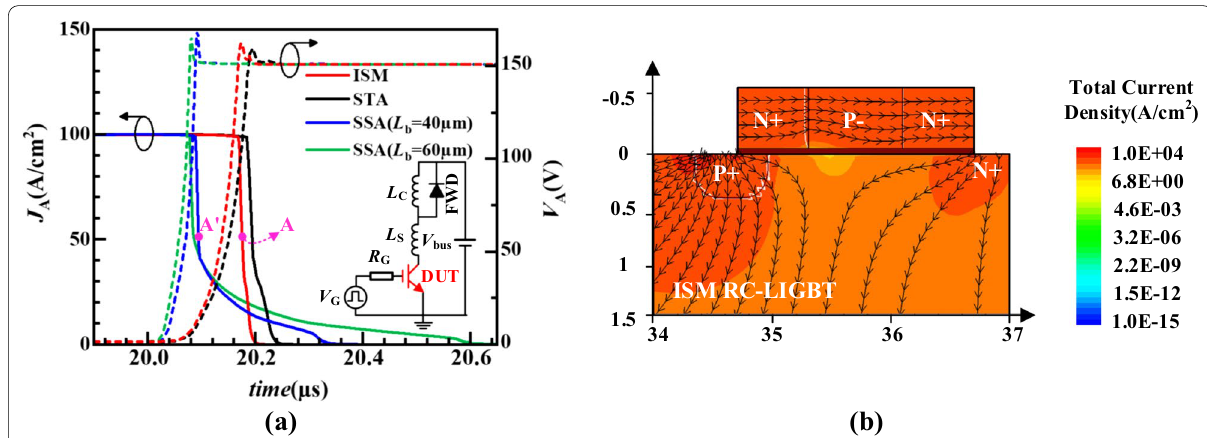
4µH, L S 1nH, R G 10 Ω, V bus 150 V, V on 1.5 V. b Electron current flowlines = = = = =